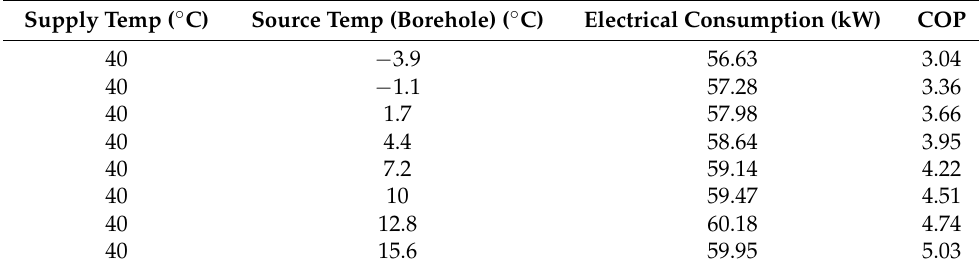
Table 2. Maritime Geothermal Ltd. W900 model GSHP performance